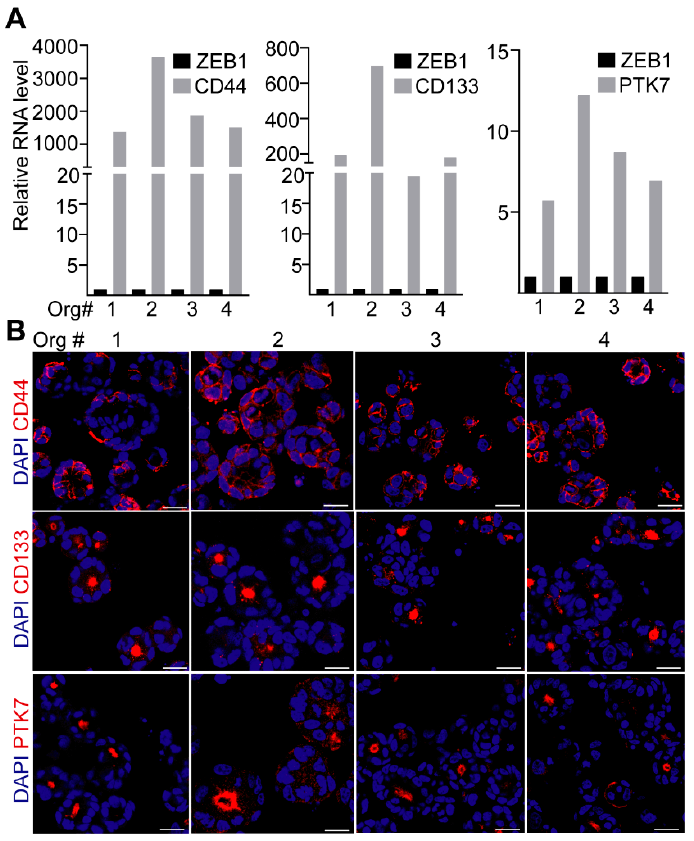
Figure 1. Heterogeneous expression of CD44, CD133, and PTK7 in CRC organoids. ( A ) The RNA level for the indicated genes in organoids #1,2,3 and #4. RNA levels were normalized to the HPRT1 housekeeping gene and then the normalized ZEB1 level was taken as 1. ( B ) Whole-mount immunostaining for CD44, CD133, and PTK7. Scale bars: 50 µm.